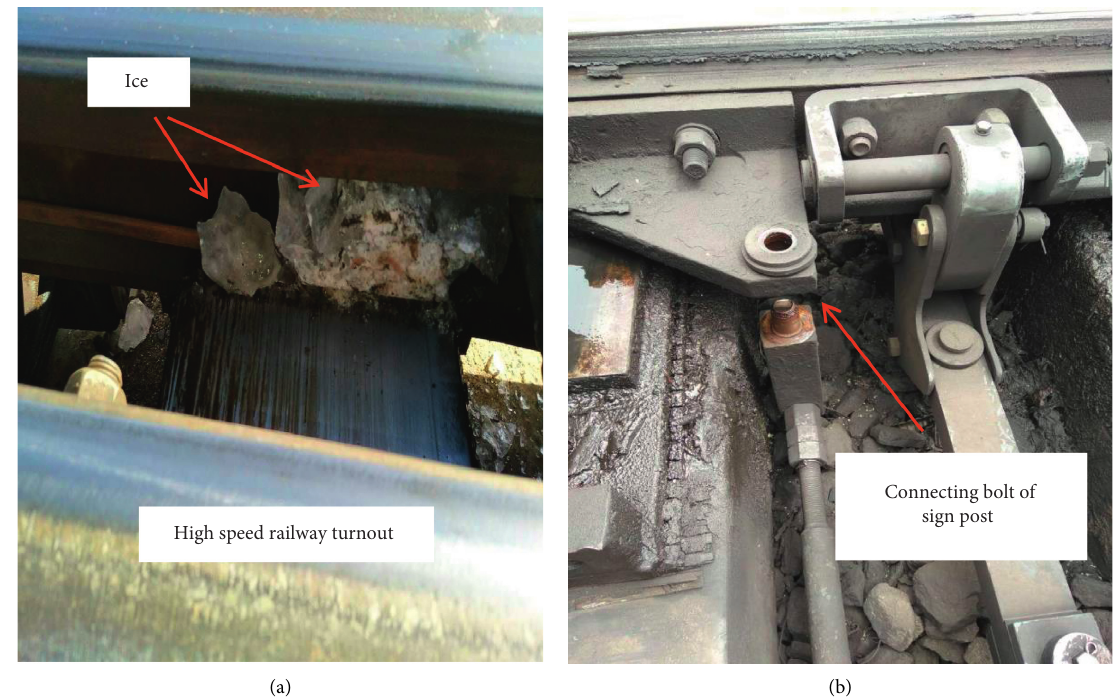
Figure 2: (a) Icing between the turnouts; (b) The connecting bolt of sign post’s joint is broken.